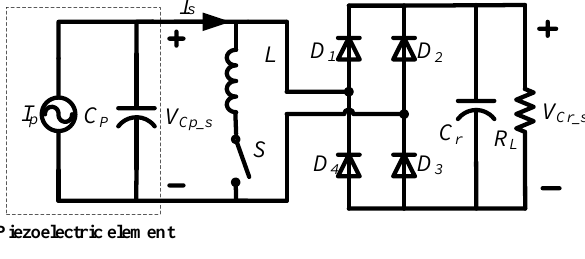
Figure 4. P-SSHI circuit schematic.